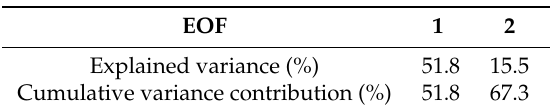
Table 3. Explained variance of the first two EOFs of the normalized precipitation amount from 25 stations in HRB from 1984 to 2014.